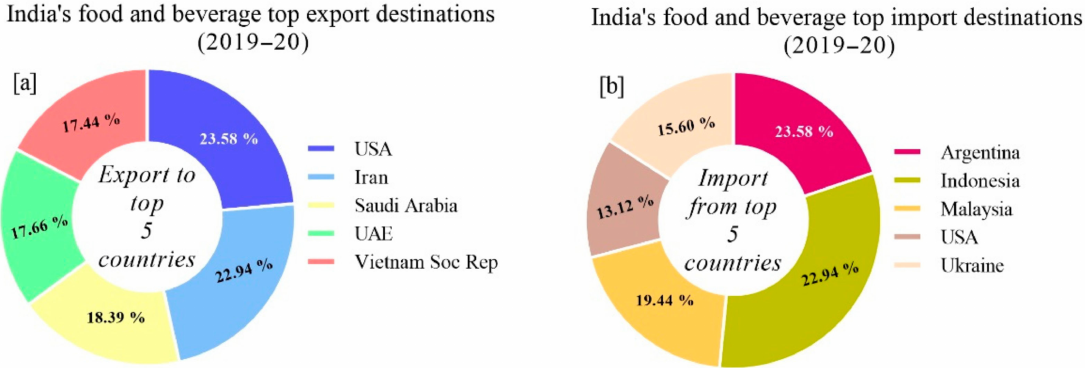
Figure 10. India’s topmost food and beverage ( a ) export and ( b ) import destinations in the world. On the other hand, India’s top five import destinations for food and beverage included Argentina 23.58%, Indonesia 22.94%, Malaysia 19.44%, Ukraine 15.60%, and United States 13.12%, respectively (Figure 10b).